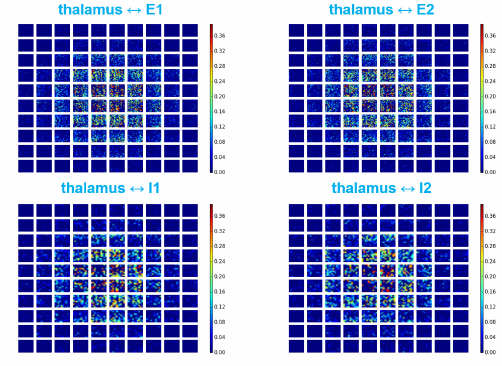
Fig. 2. Connectivity between thalamus and V1 as in [16].